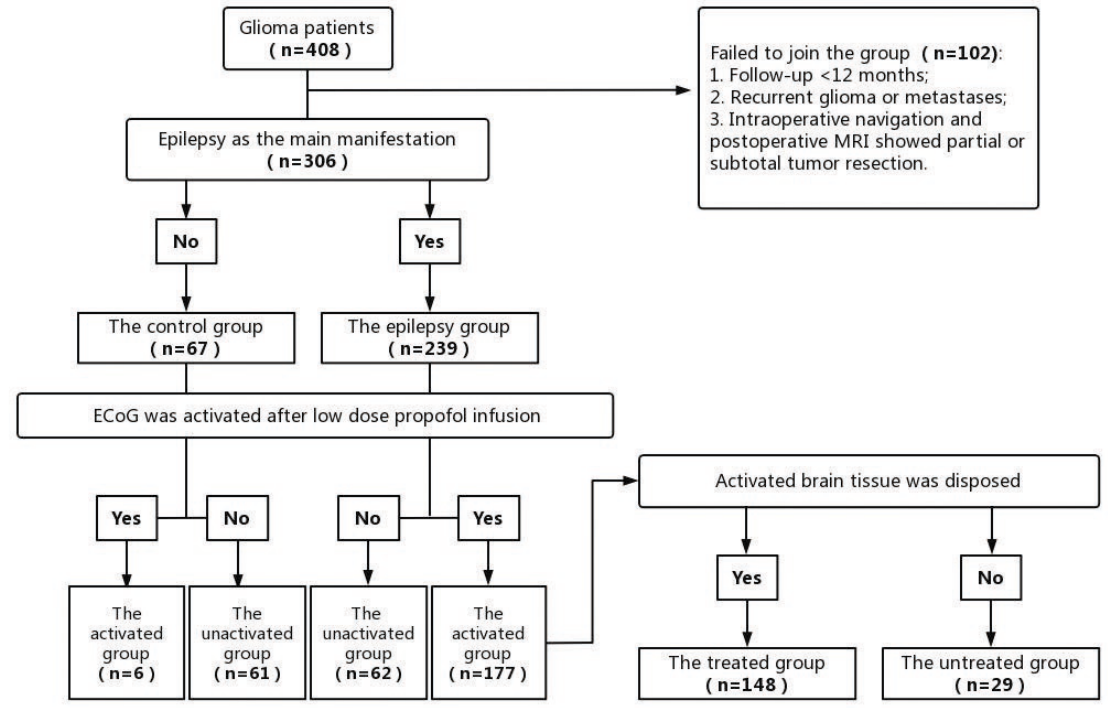
Figure 1. Patient enrollment process.